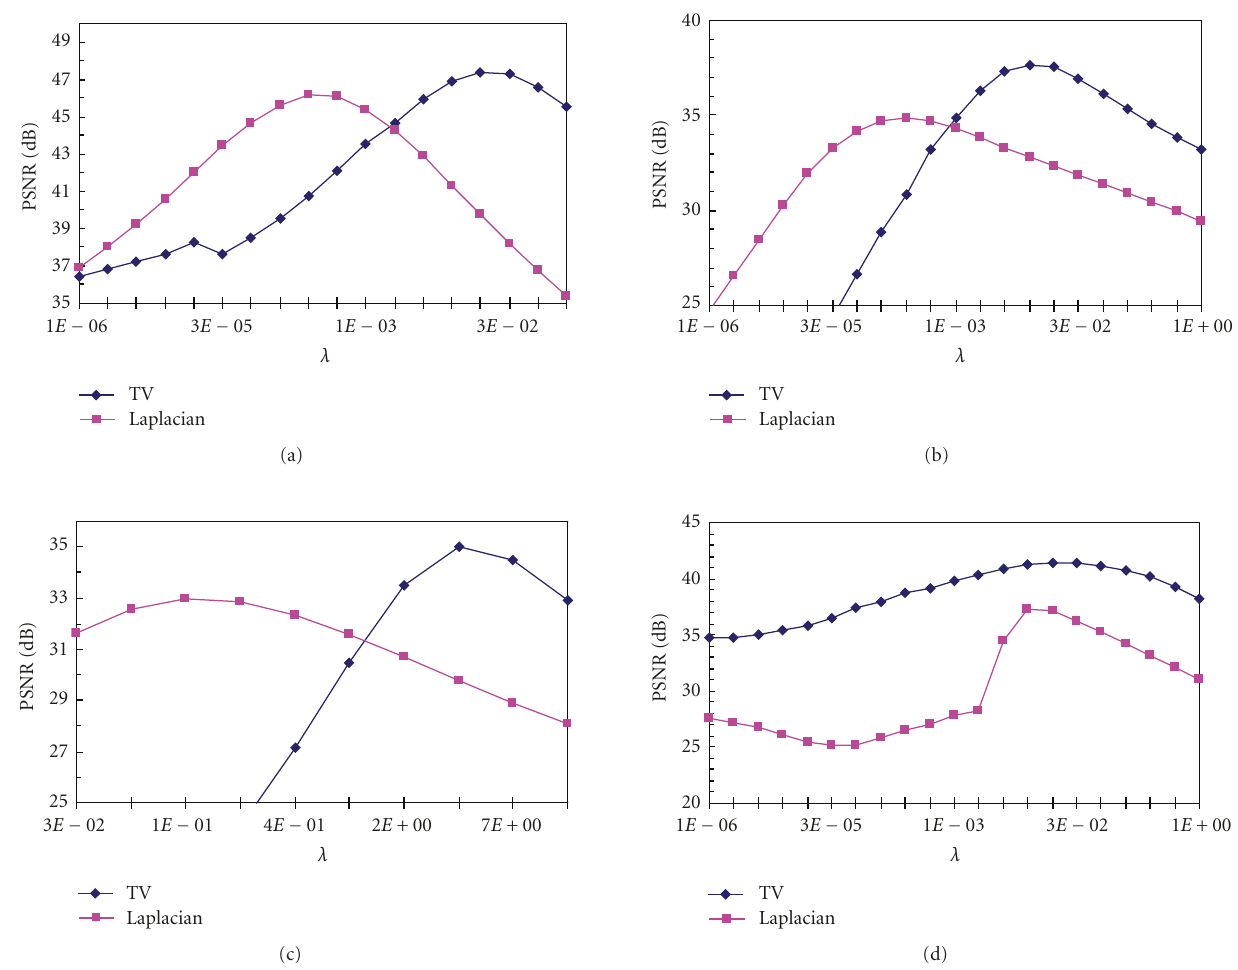
Figure 4: PSNR values versus the regularization parameter in the synthetic “Foreman” experiments: (a) the “motion only” case, (b) the “blurring” case, (c) the “noise” case, and (d) the “missing”